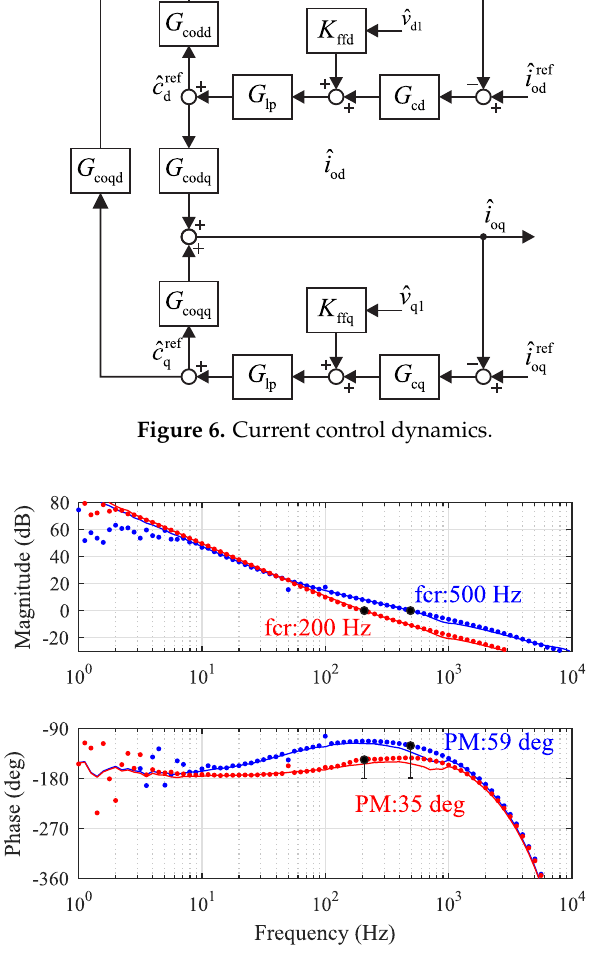
Figure 7. Modeled (solid) and measured (dotted) loop gain of d-current control for two different parameter